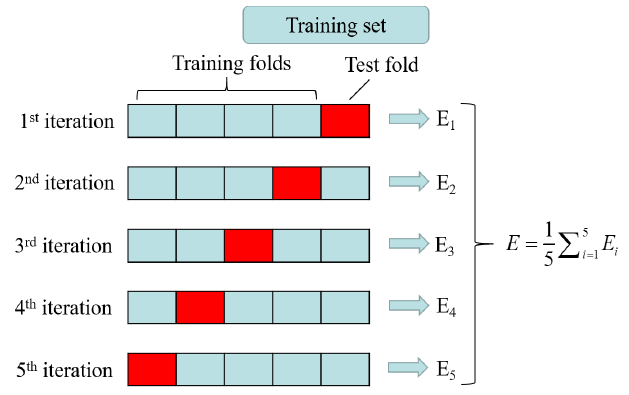
Figure 11. Fivefold cross-validation